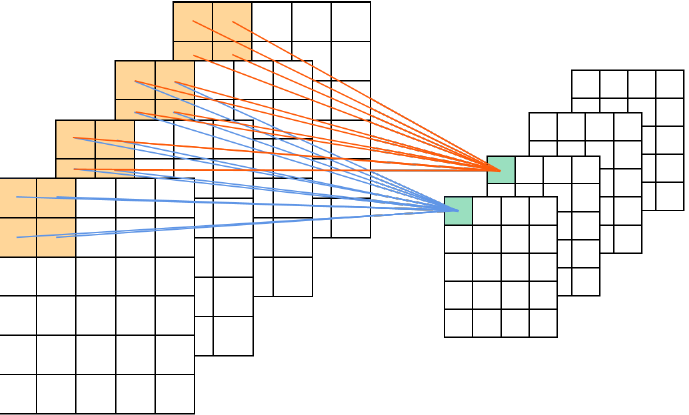
Figure 6. Hand spatial-temporal data matrix convolution process diagram.